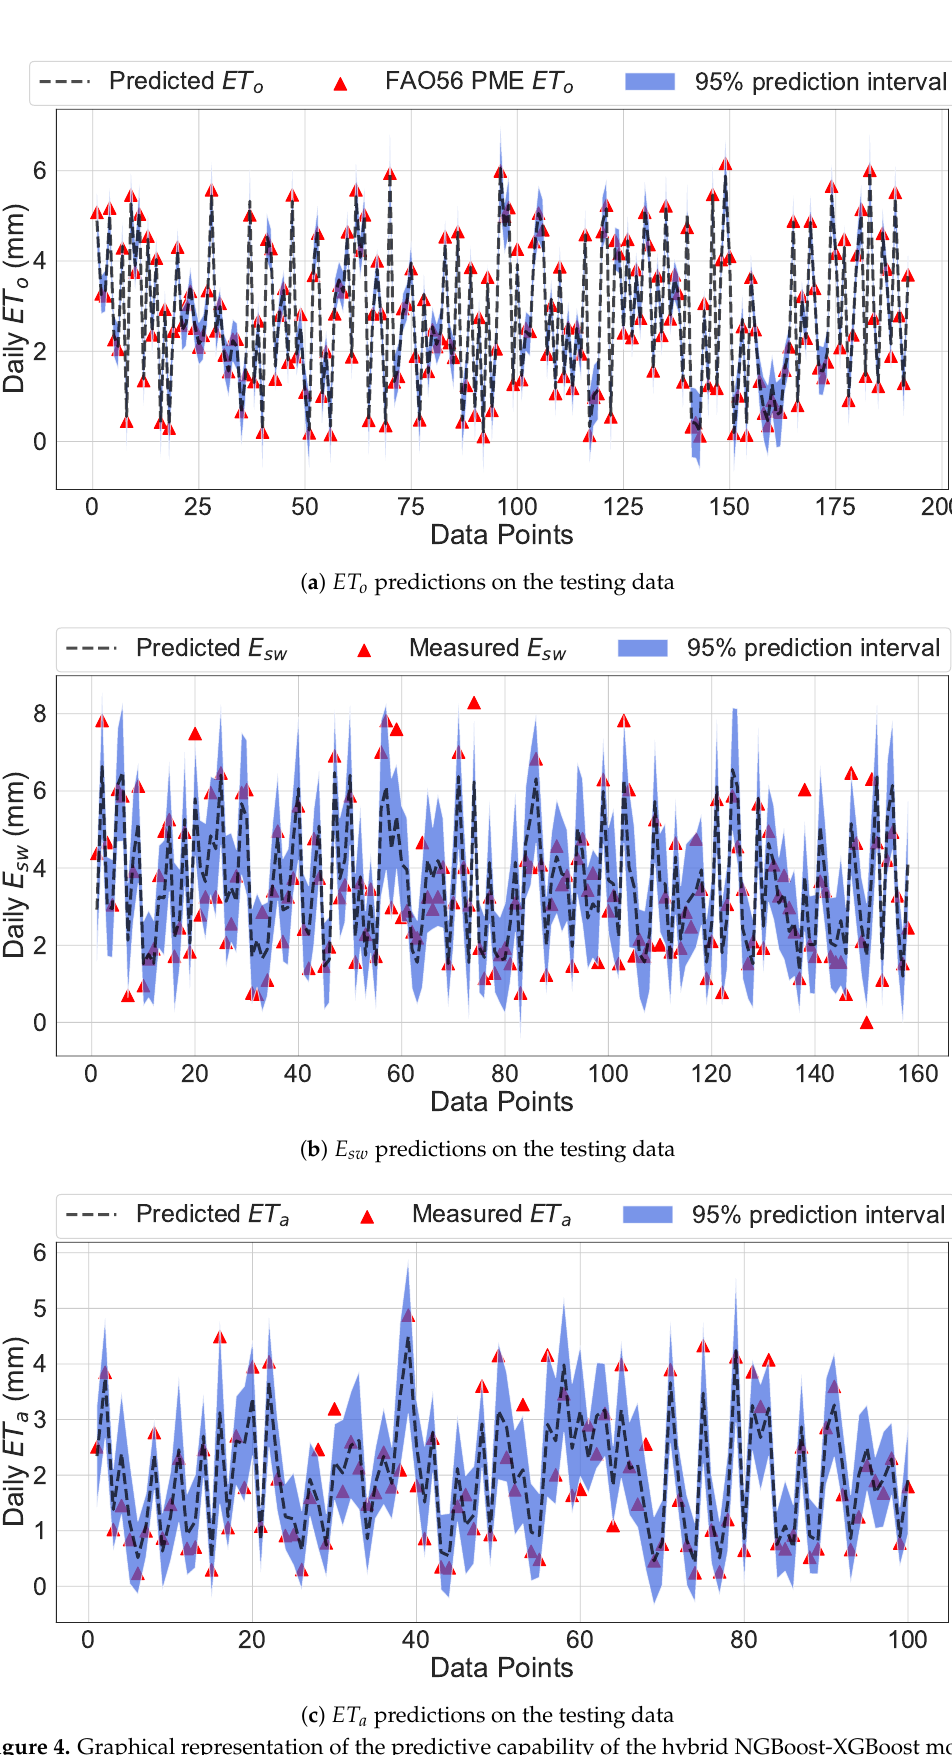
Figure 4. Graphical representation of the predictive capability of the hybrid NGBoost-XGBoost